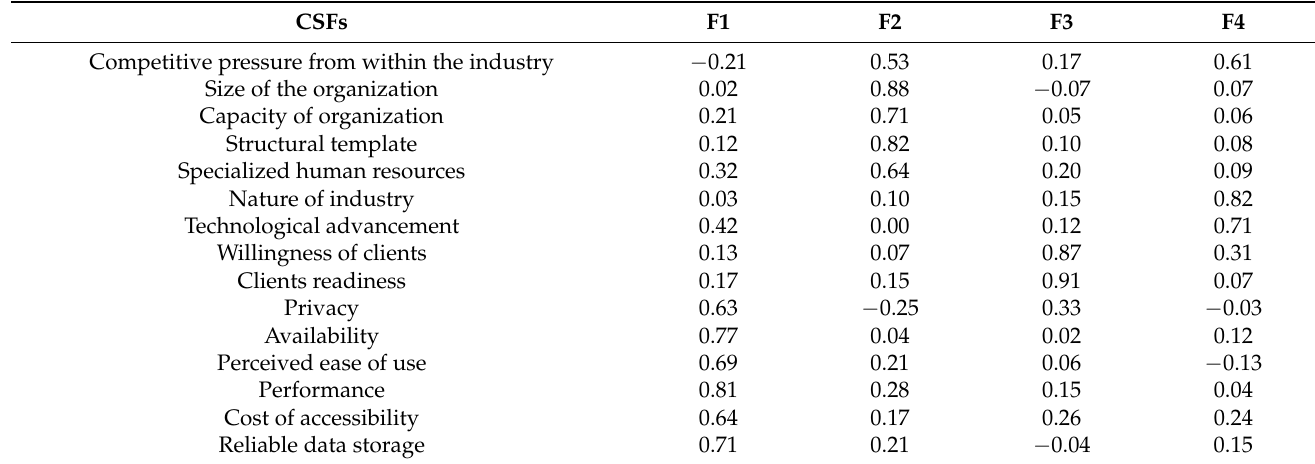
Figure 3. The scree plot of loading of the success factors influencing the adoption of Cloud Computing in Nigerian construction industry. Table 6. Success Factors Rotated Component